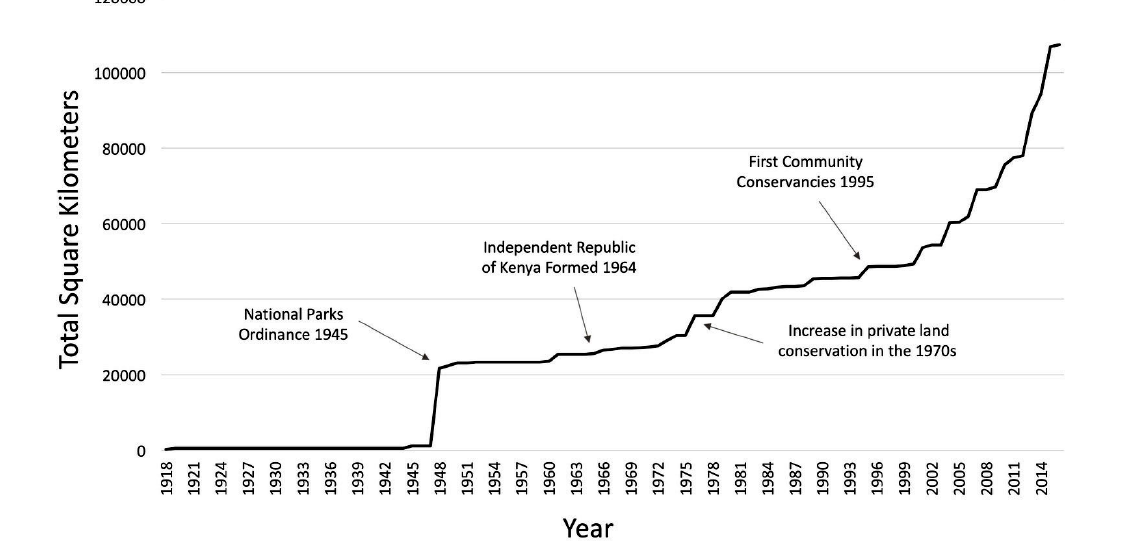
Fig. 2 . Total area under all types of formal conservation protection (national parks, national reserves, private conservation areas, and community conservation areas) compiled from the Kenya Wildlife Conservancies Association Membership and public data from International Livestock Research Institute, private web sites, Protected Planet, and National Government of Kenya